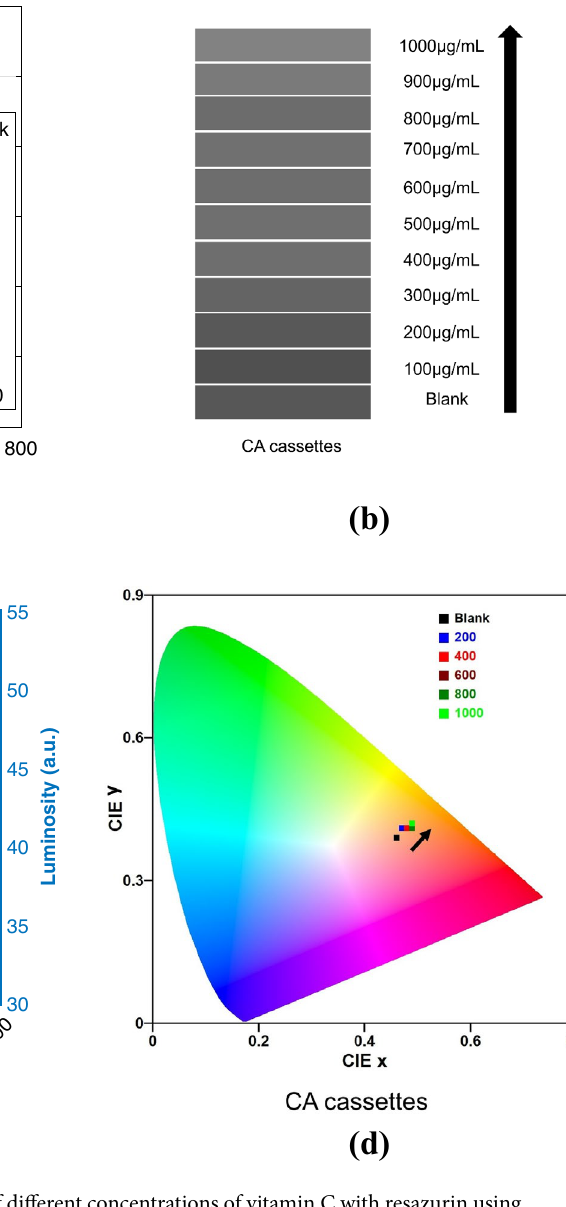
Figure 6. ( a ) Fluorescence intensity profile of different concentrations of vitamin C with resazurin using a spectrophotometer. The legends have the unit µ g/mL. ( b ) Gray-scale shade cards corresponding to the luminosity values for different concentrations of vitamin C for CA cassettes ( c) ) Overlap of fluorescence intensities (left y-axis) obtained from a spectrophotometer and the luminosity values (right y-axis) extracted from the mobile phone-based detector for CA. ( d ) CIE chromaticity diagram for different concentrations of vitamin C in CA